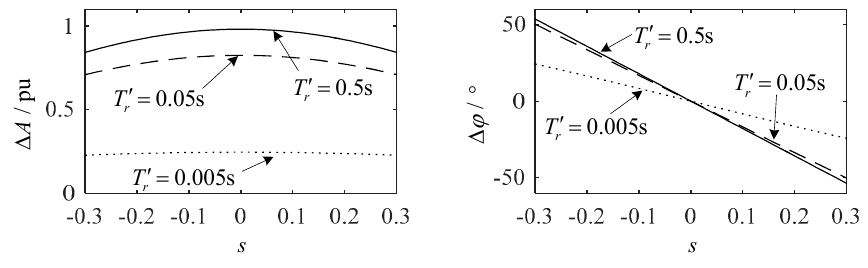
s . Figure A1. The relationship of ∆ A and ∆ ϕ with T (cid:48) T  and r and s . r